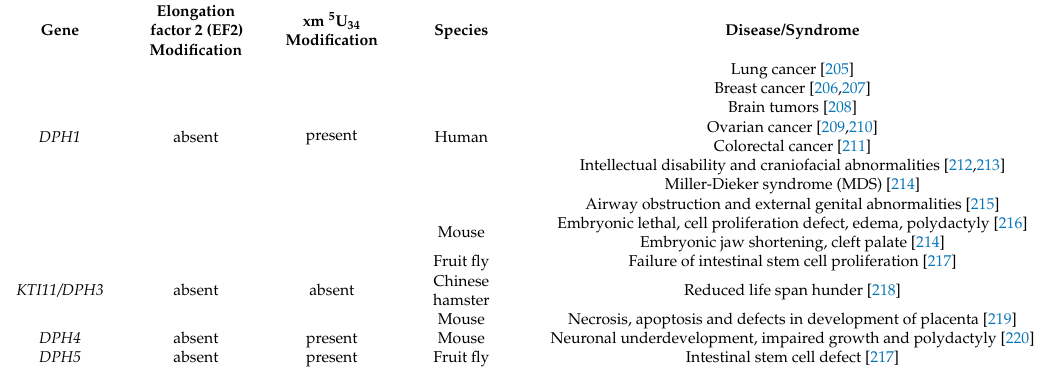
Table 3. Diphthamide synthesis genes and defects linked to disease syndromes in higher eukaryotes.